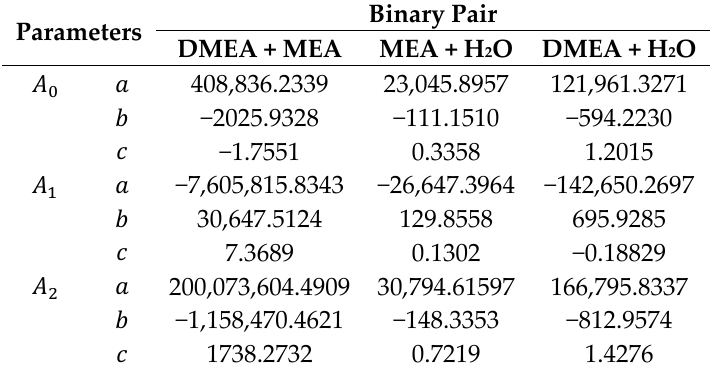
Table 15. Binary parameters 𝐴 0 , 𝐴 1 , and 𝐴 2 of the equation Δ𝐺 𝑗𝑘𝐸∗ = 𝑥 𝑗 𝑥 𝑘 ∑ 𝐴 𝑖 (𝑥 𝑗 − 𝑥 𝑘 ) excess free energy of activation for the viscous flow of DMEA (1) + MEA (2) + H 2 O (3).